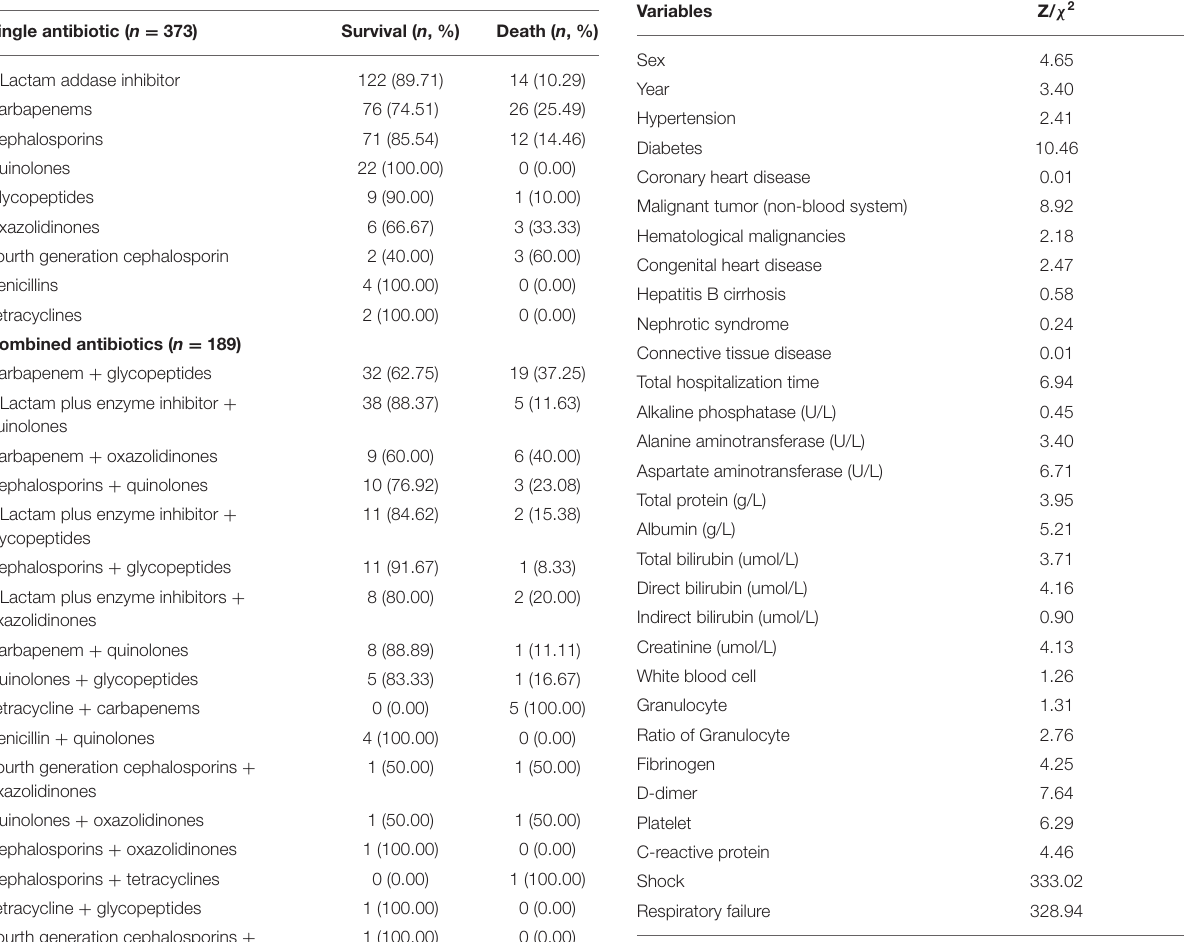
TABLE 5 | Univariate analysis of patients with streptococcal bloodstream infection. Variables